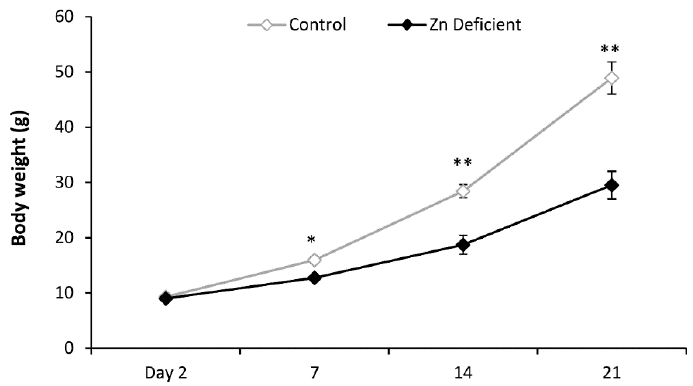
Figure 1. Body weight of control and zinc-deficient (Zn-deficient) pups during lactation period. Values are the mean ± standard error of mean (SEM) of grams of body weight, ( n = 6/group). Fisher’s post-hoc test showed significant differences: * p < 0.01, ** p < 0.001 vs. control group.